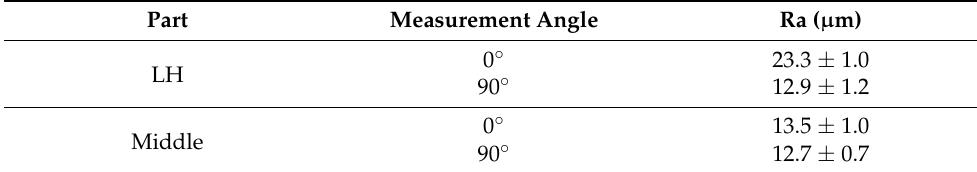
Table 2. Surface roughness of as-sintered parts.